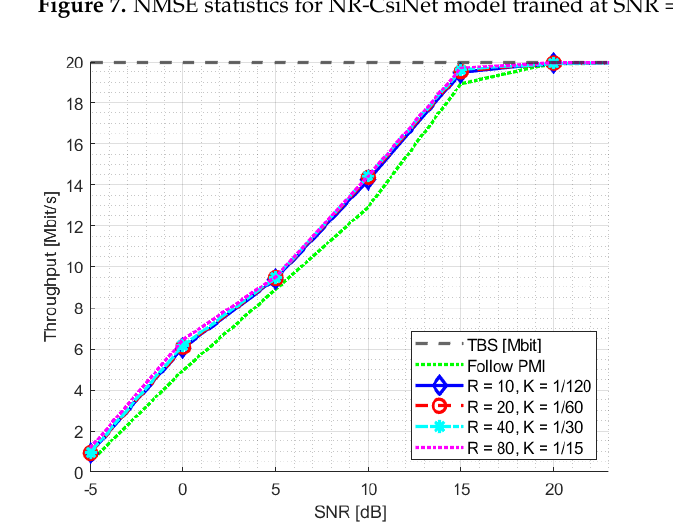
Figure 8. Throughput statistics for NR-CsiNet model trained at SNR = 10